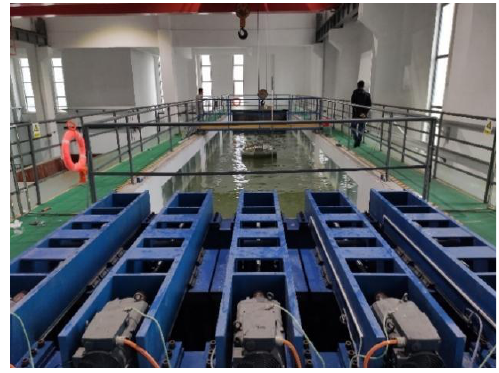
Figure 4. Wave tank. Figure 4. Wave regular wave based on the Pierson – Moskowitz (PM) spectrum with different parameters were set as wave excitation conditions. The parameters of wave height H and period T of height Hs and spectral peak period Tp of the irregular waves based on the PM spectrum are shown in Table 2. Table 1. The parameters of linear regular waves. Wave Type